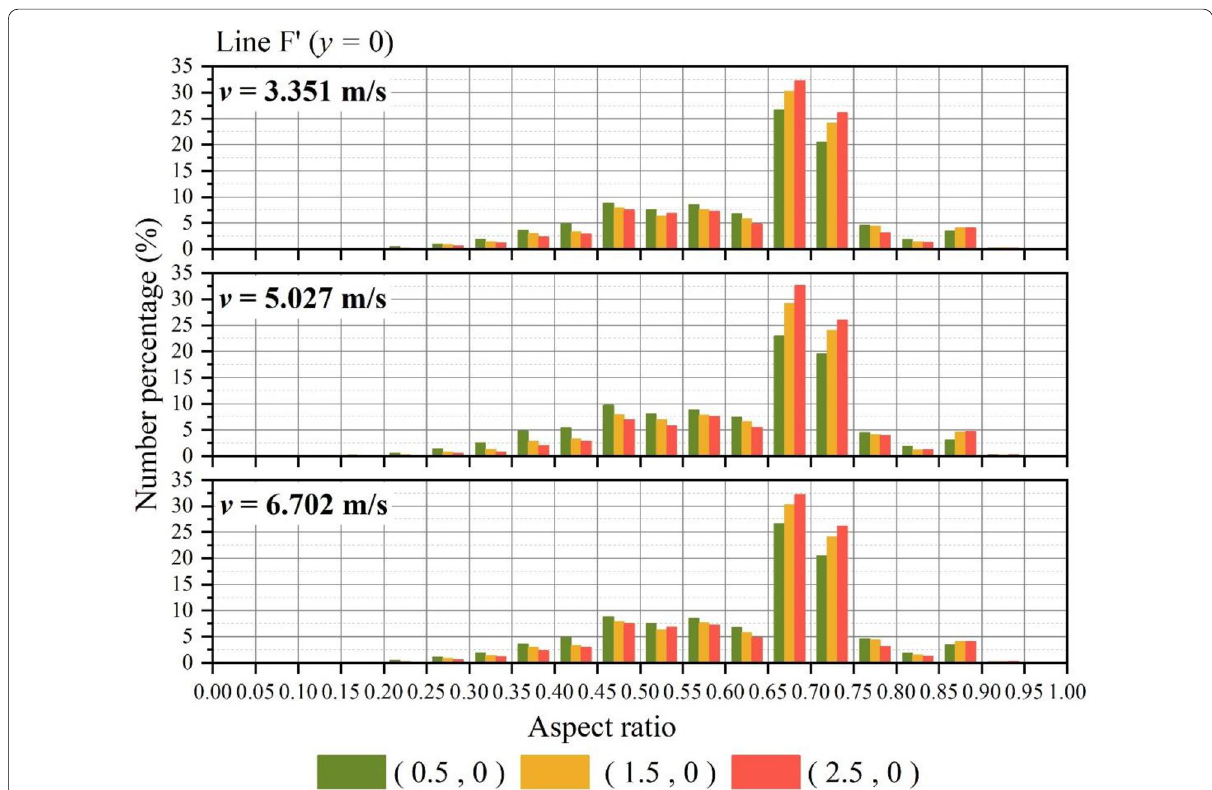
Fig. 10 The aspect ratios of dust particles collected from sampling points at the coordinates of (0.5, 0), (1.5, 0) and (2.5, 0)